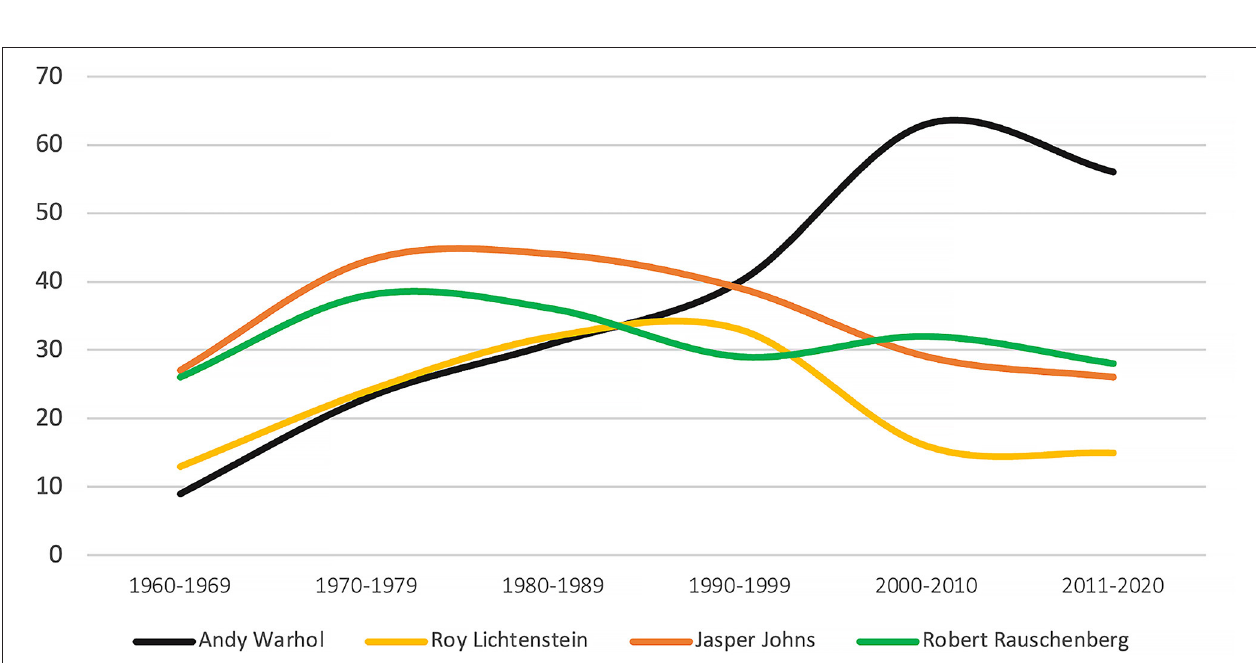
FIGURE 2 | Number of exhibitions at the Leo Castelli Gallery (1960–1989). Source: Developed by the authors based on data from Castelli Gallery online archive.